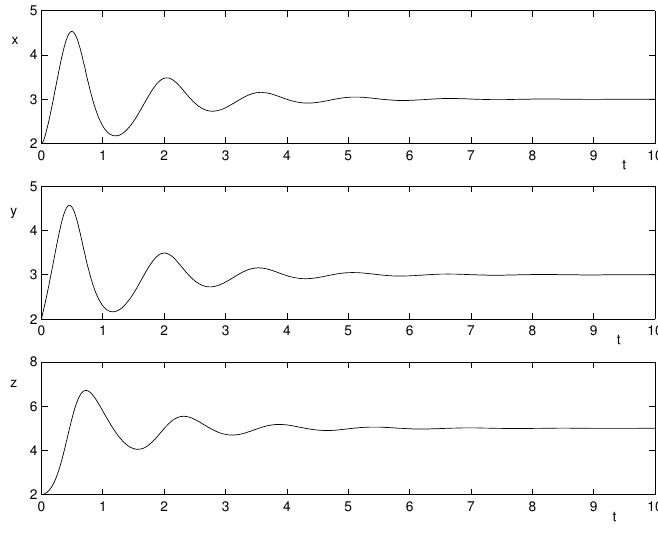
Figure 2. Time response of the Lorenz system for σ =